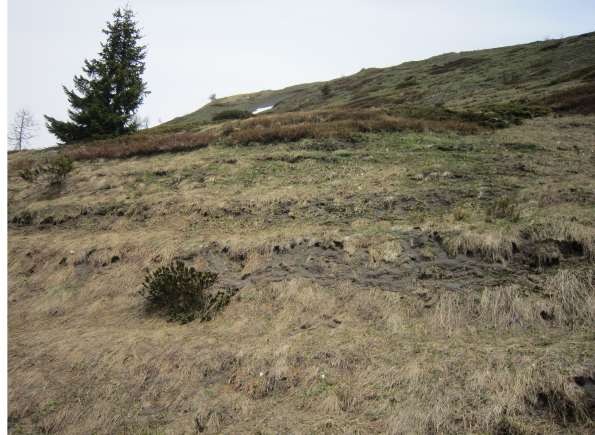
Fig. 8. Particle sedimentation in the Above Snow Bridges (ASB) area after the snow